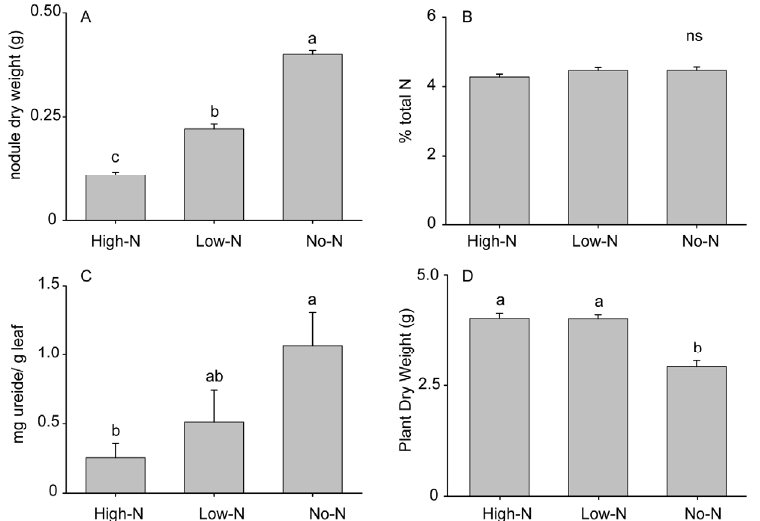
Figure 1. Characteristics of 5-week old plants inoculated with rhizobia, but given different levels of nitrogen fertilizer: ( A ) nodule dry weight; ( B ) percent total nitrogen; ( C ) ureide concentration (as allantoin) in the leaves; ( D ) aboveground plant dry mass. High-N = High N fertilizer treatment, Low-N = Low N fertilizer treatment, and No-N = no fertilizer. Different lowercase letters indicate significant differences for that characteristic, while